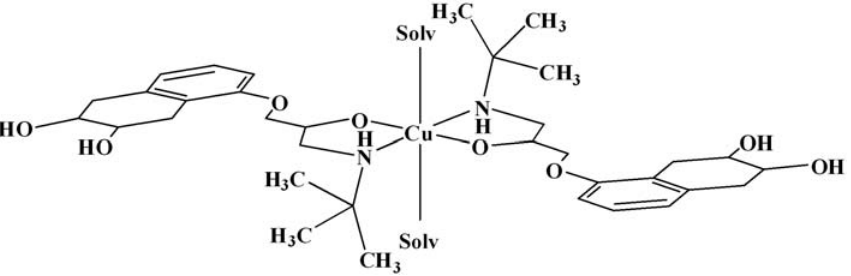
Fig. 3 Proposed structure of the mononuclear Cu(II) complex of nadolol,